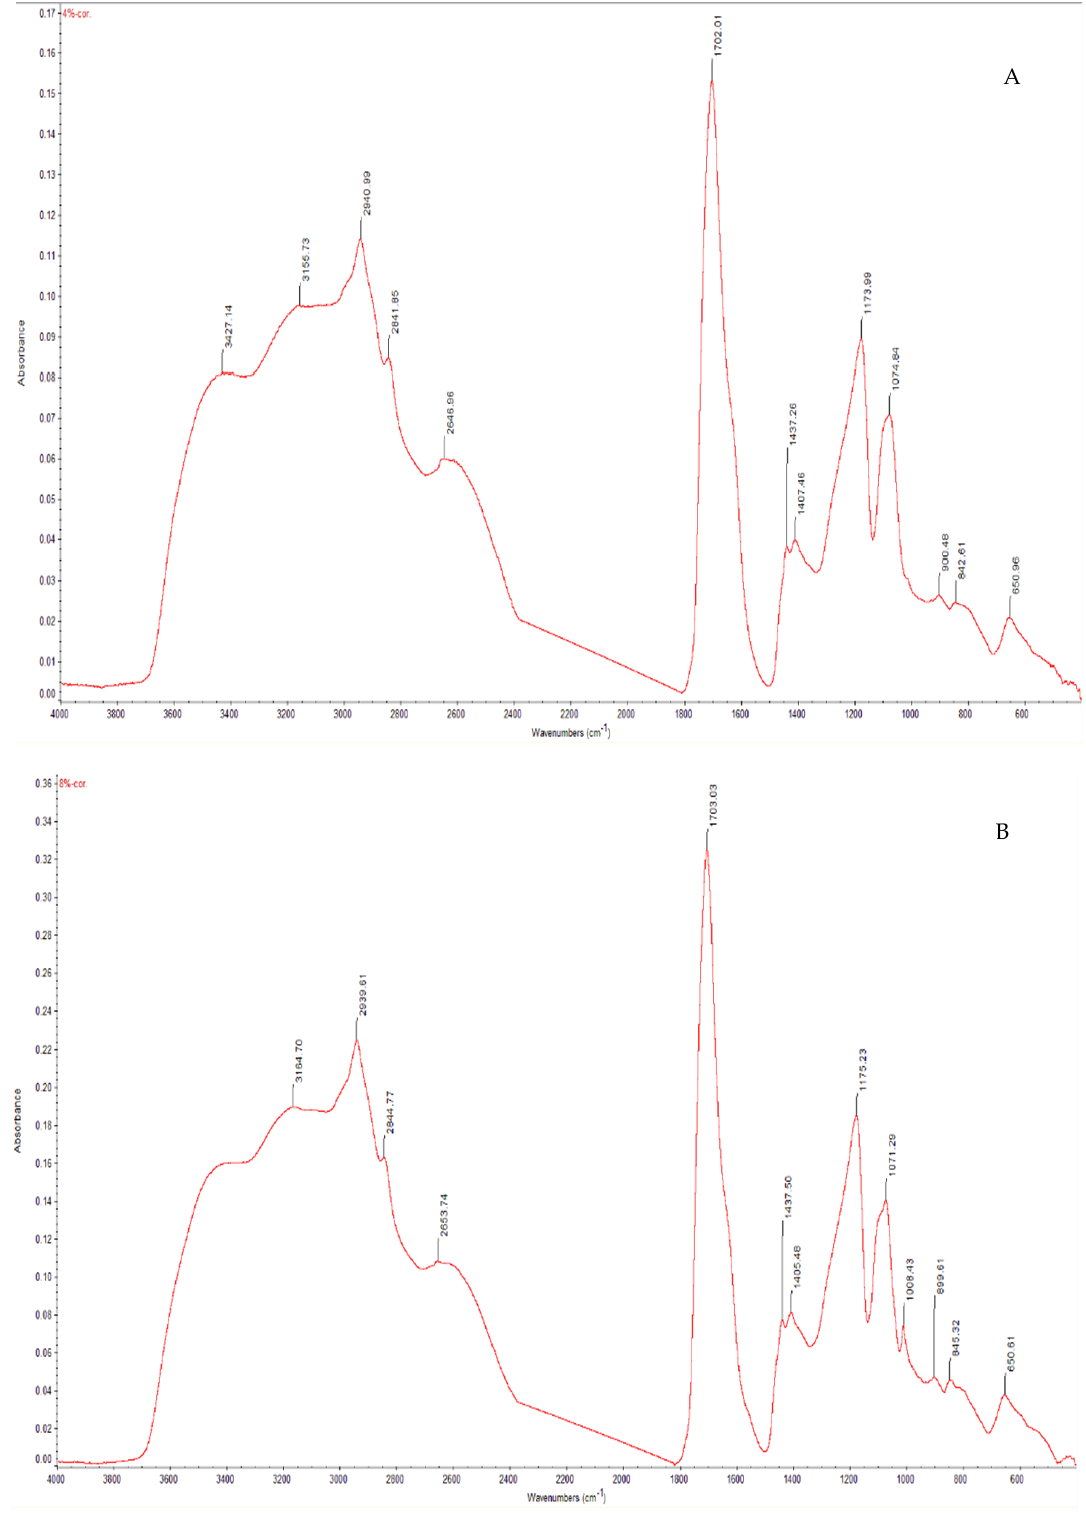
Figure 6. FTIR spectra from ( A ) 4% amphotericin B-loaded microneedles, and ( B ) 8% amphotericin B-loaded microneedles.